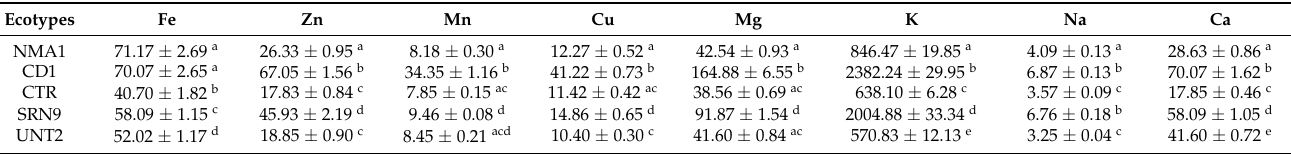
Table 2. Mineral content (mg/100 g fresh pulp) of cocona fruits NMA1, SRN9, CD1, CTR, UNT2 ecotypes.